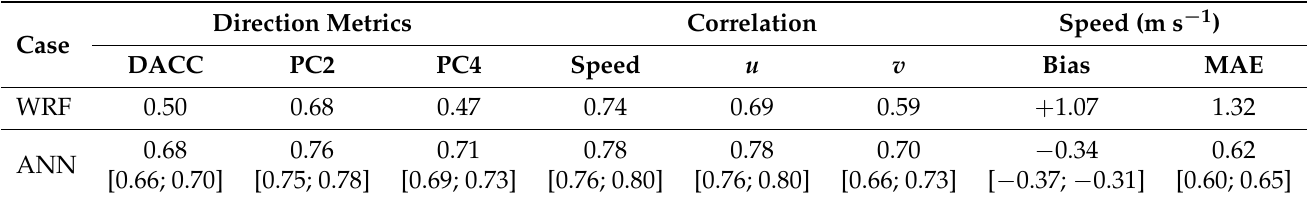
Figure 9. Same as Figure 8 for a comparison between the artificial neural network (ANN) and observations ( a ) for direction and ( b ) for speed. Table 4. Summary of ANN performance in forecasting 2 m winds at the MET01 position and comparison with WRF results. For the ANN, the mean value of the metrics is on the upper line and the confidence interval at 90% on the lower line, between brackets.